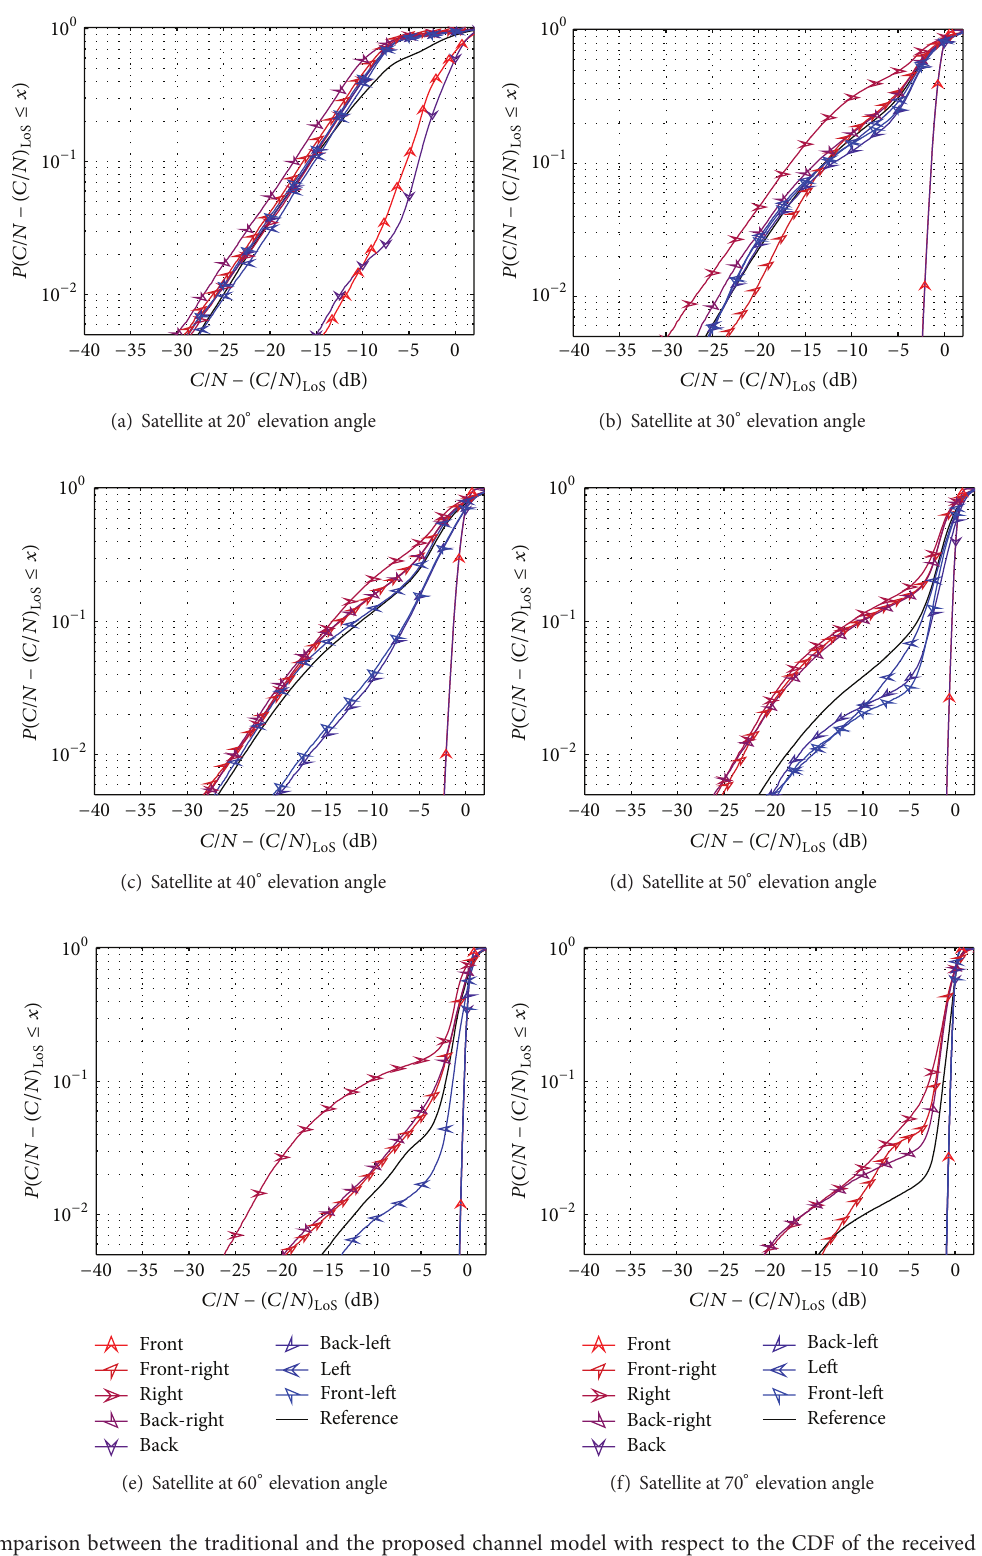
Figure 16: Comparison between the traditional and the proposed channel model with respect to the CDF of the received satellite signal envelope. For the results we consider data that has been collected in urban environment and each plot is related to a different elevation